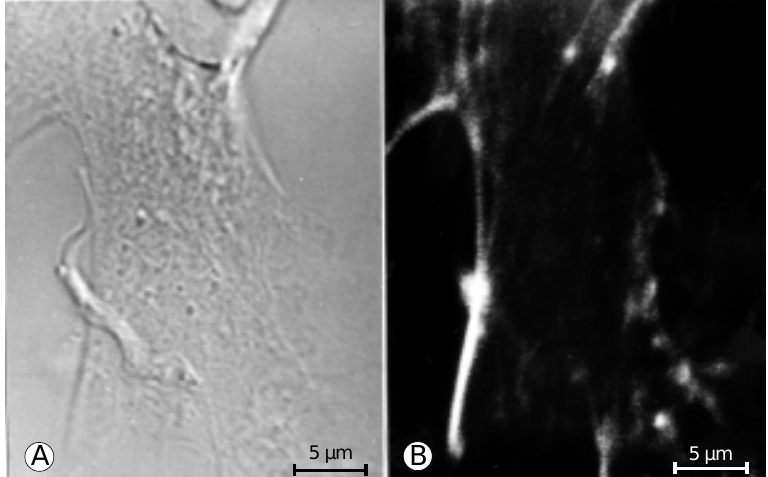
Figure 7 - Concentration of actin microfilaments observed at the point of initial contact of a trypomastigote form of Trypanosoma cruzi with the host cell. Bar = 5 µm. A, Interference contrast microscopy; B, CLSM.